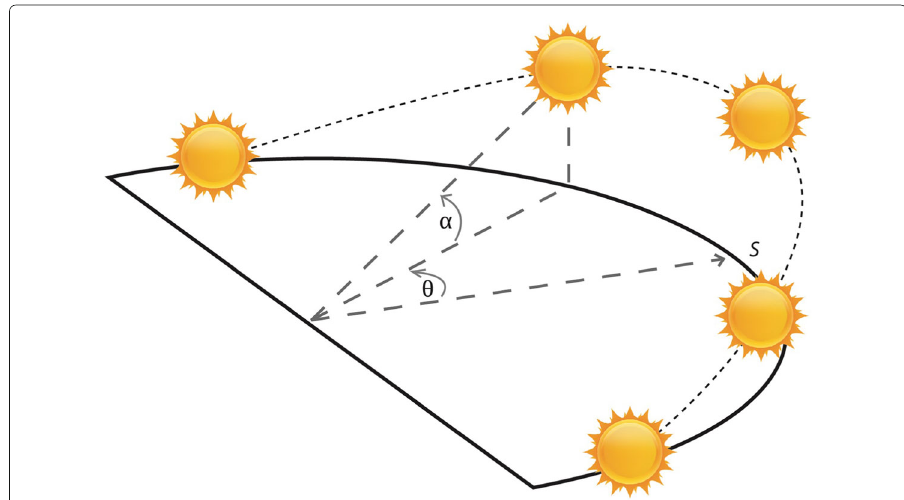
Fig. 5 Solar angles (reproduced with permission from (Khatib and Elmenreich 2016))